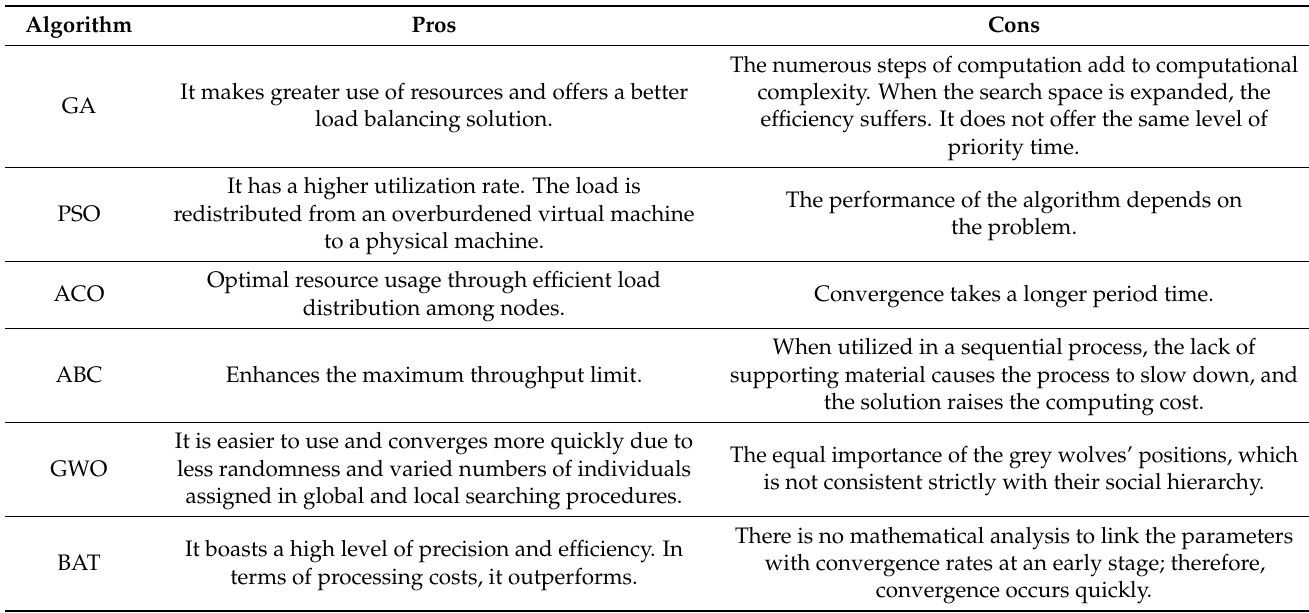
Table 4. Pros and cons of traditional SI